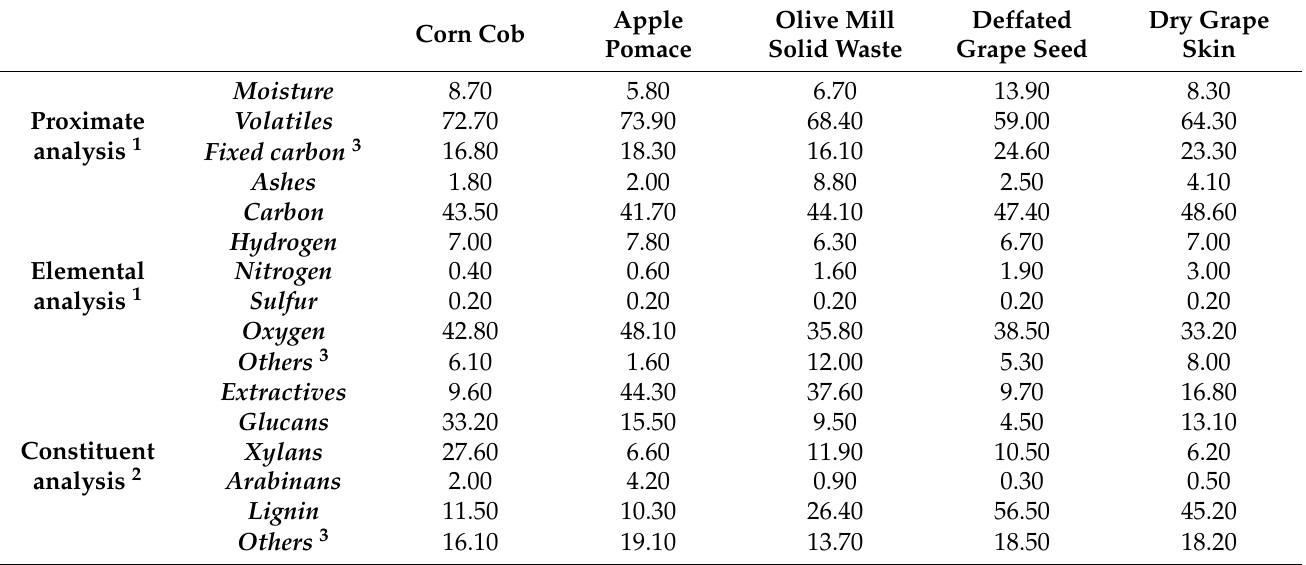
Table 1. Proximate, elemental and constituent analysis of the raw precursors (wt.%).